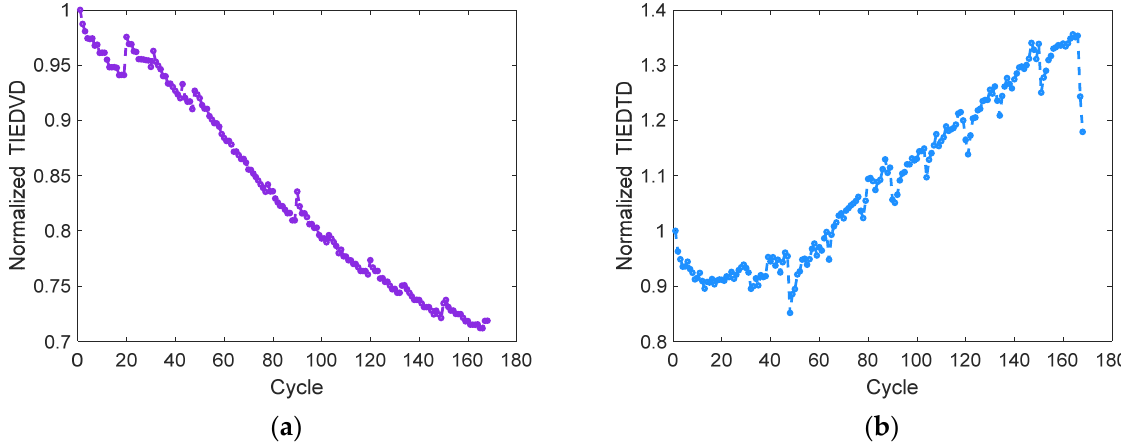
Figure 3. Changes of the selected features with cycle numbers. ( a ) TIEDVD; ( b ) TIEDTD.